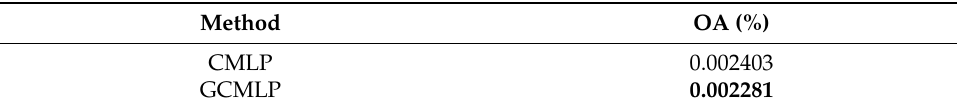
Table 6. Comparison with GCMLP and